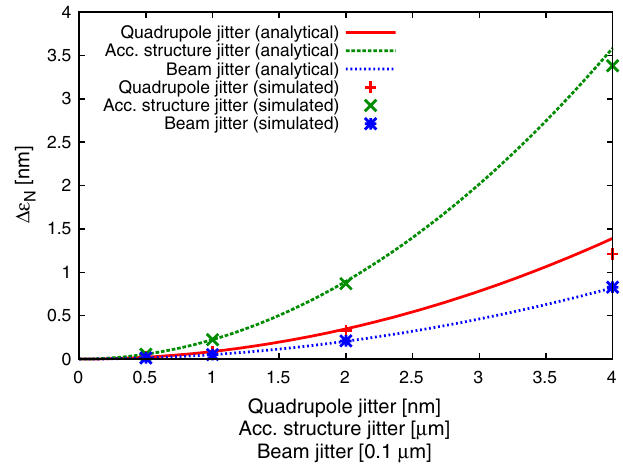
FIG. 2. (Color) Jitter-induced emittance growth according to analytic estimates and simulations,